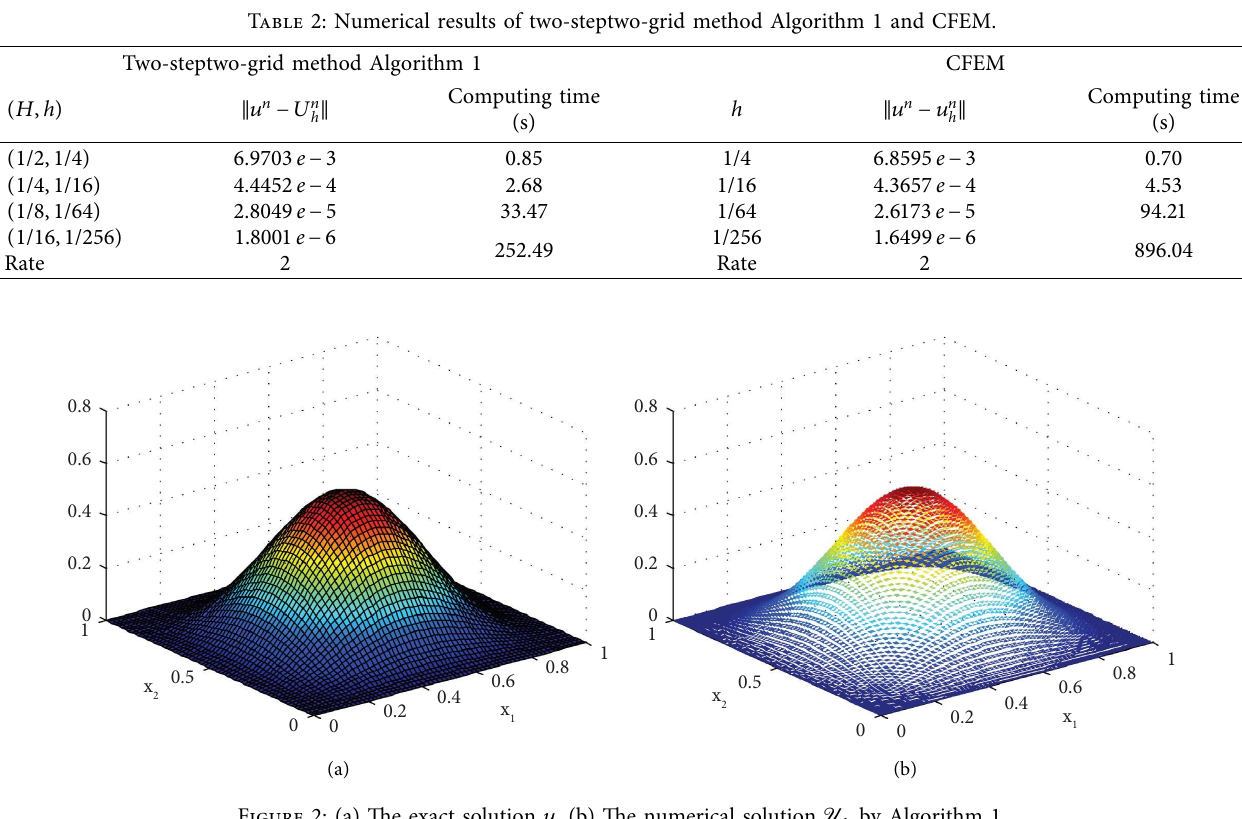
h by Algorithm 1.